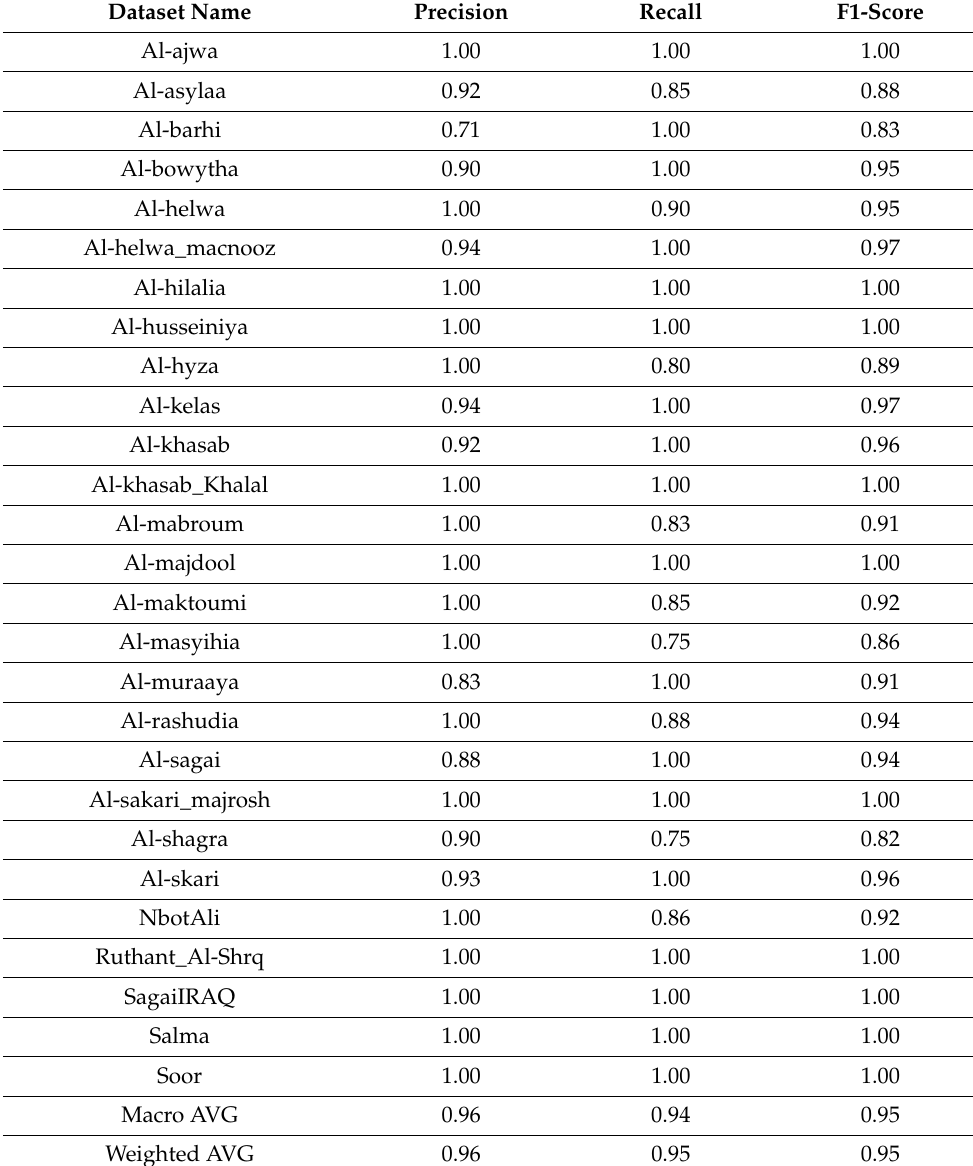
Table 11. Overall date fruit classes’